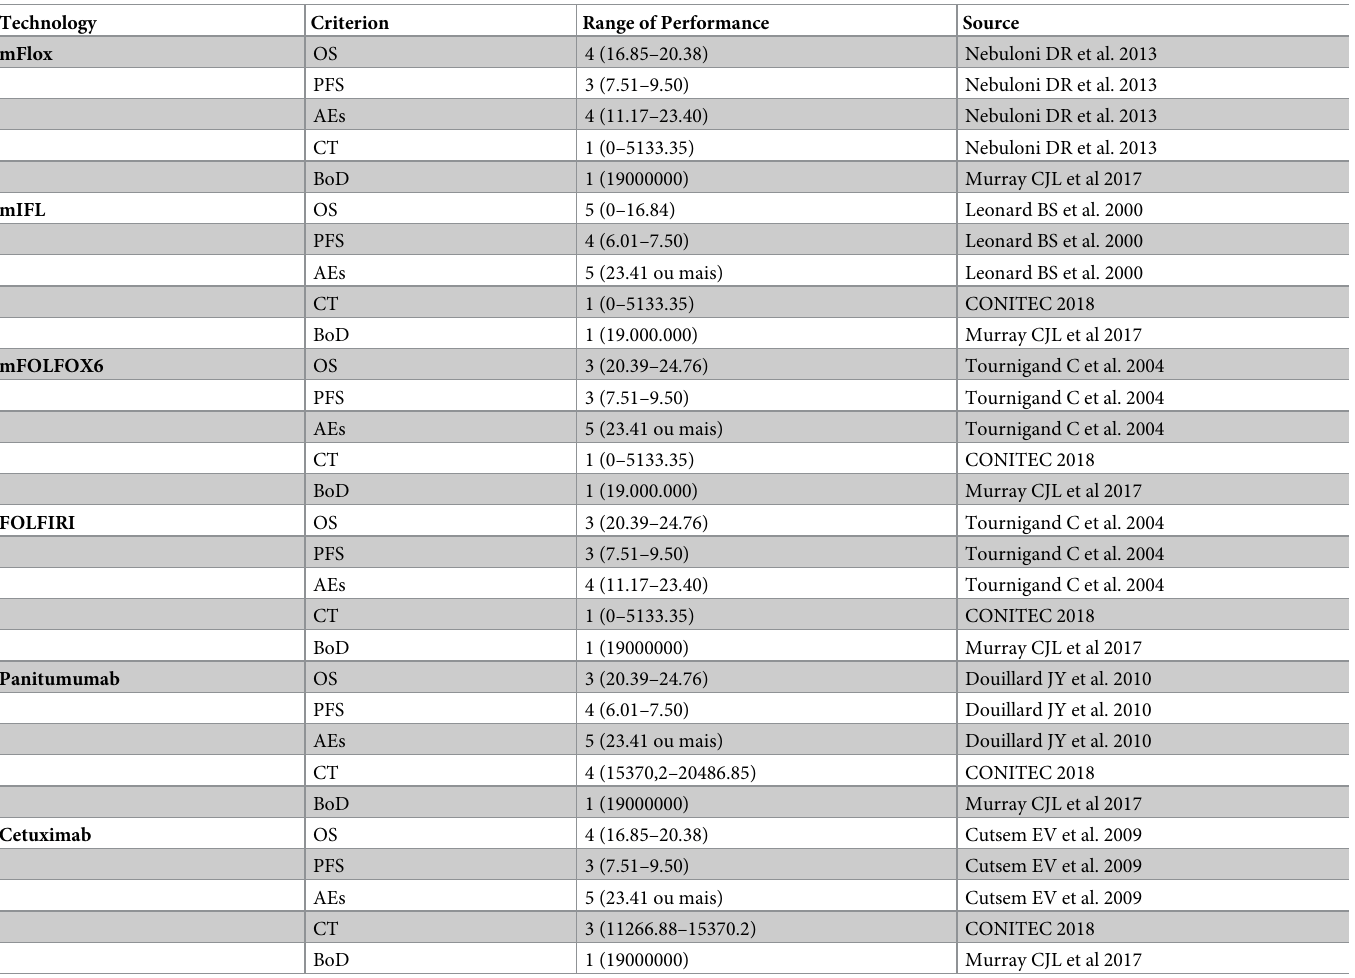
Table 2. Technologies, criteria, ranges of performance and